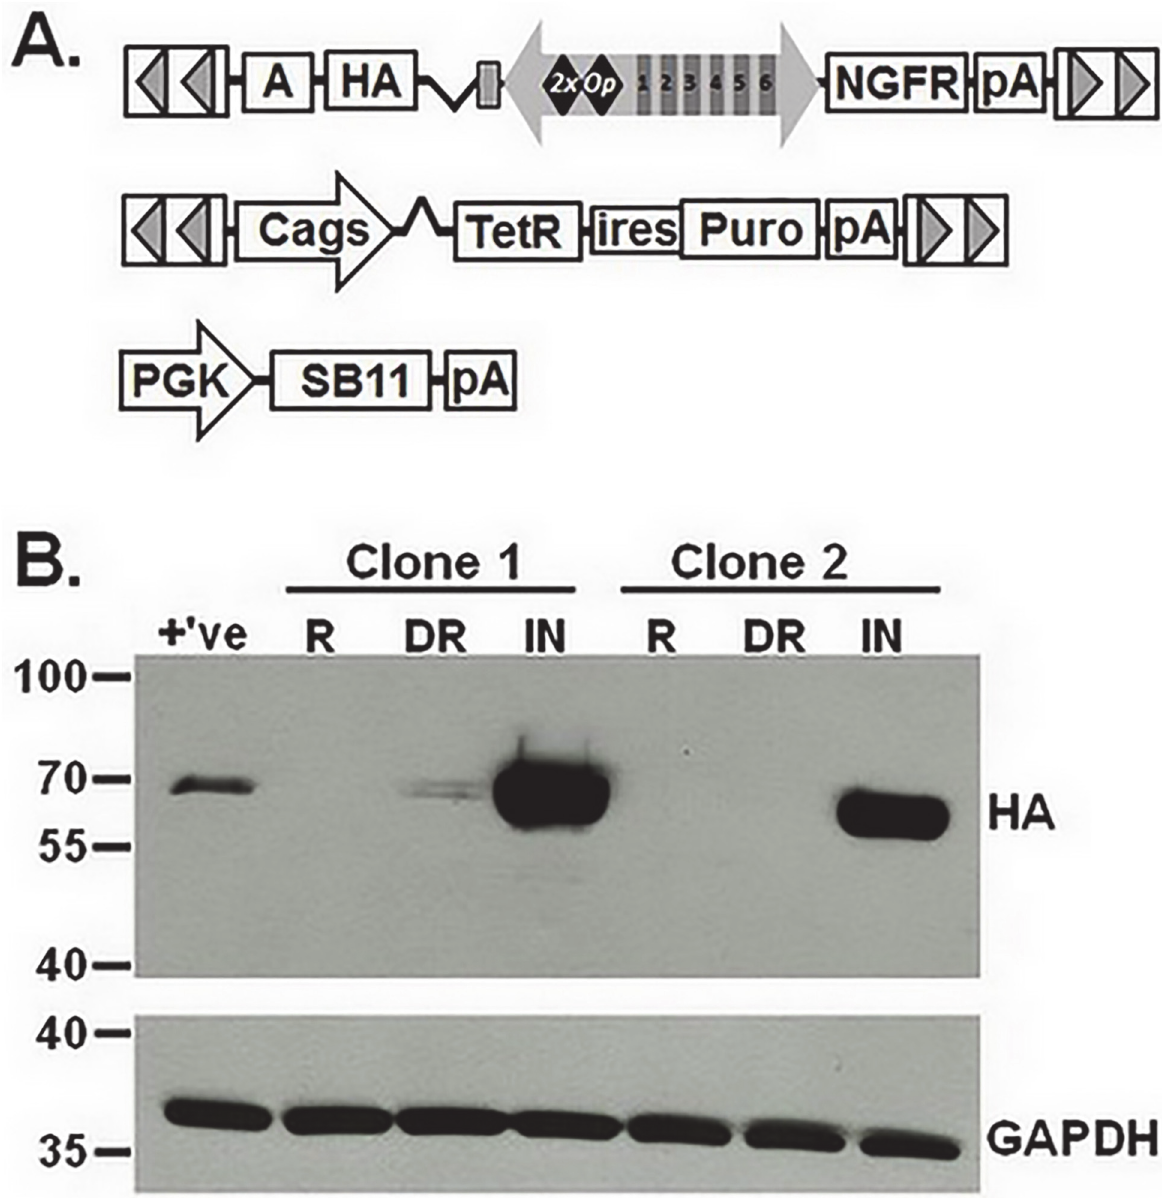
Fig 6. Improved utility of the inducible, bidirectional system by transposon delivery of the tetracycline repressor protein. (A) Sleeping Beauty (SB) transposons encoding for inducible expression of influenza A virus hemagglutinin (HA) gene (HA-IE-N) or bicistronic expression of the tetracycline-repressor (TetR) and puromycin resistance gene (Puro) were cotransfected with SB transposase (PGK-SB11) into HeLa cells to create cell lines with regulated levels of HA. (B) Western blot of total cell lysates prepared from two cell lines cultured in the absence of doxycycline (repressed, R), presence of 4 μ M doxycycline (de-repressed, DR), or when doxycycline treated cells were transduced with adenovirus vector particles (m.o.i. = 3) encoding for expression of VP16 (induced, IN). Membranes were reacted with antibodies to HA or GAPDH, which served as a loading control. Molecular weights (kDal) are indicated. PGK, human phosphoglycerate kinase promoter; Cags, chimeric CMV enhancer:chicken beta-actin promoter; ires, internal ribosome entry site; pA, BGH polyadenylation signal; A; SV40 polyadenylation signal.